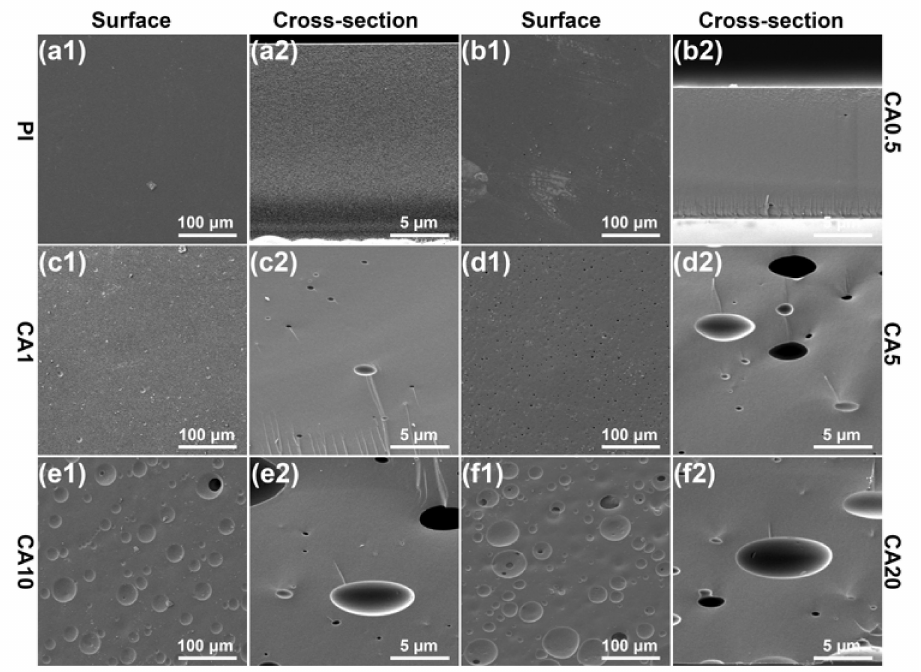
Figure 11. SEM images of CMSMs: ( a 1– f 1) and ( a 2– f 2) are the surfaces and cross sections of PI, CA0.5, CA1, CA5, CA10, CA20 CMSMs,